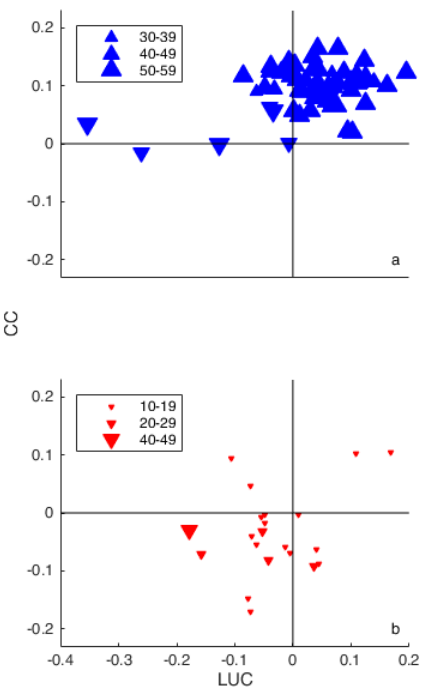
Figure 11. Contribution of land use change ( x -axis) and climate change ( y -axis) for ( a ) the American and ( b ) Australian catchments with a significant trend in discharge and significant LUC and/or CC values. The length of the total measuring period is indicated by the symbol sizes and shown in years.